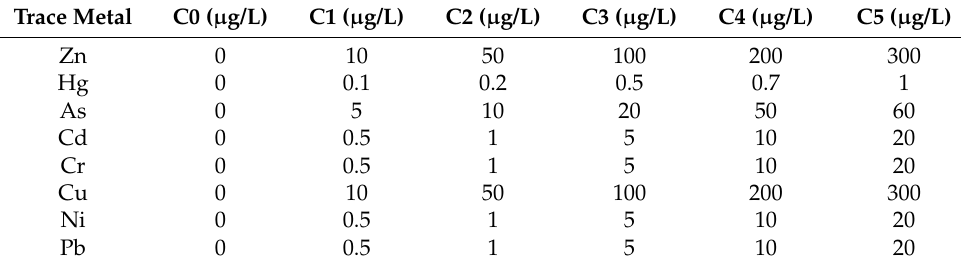
Table A2. Standard series of solutions concentration (water).